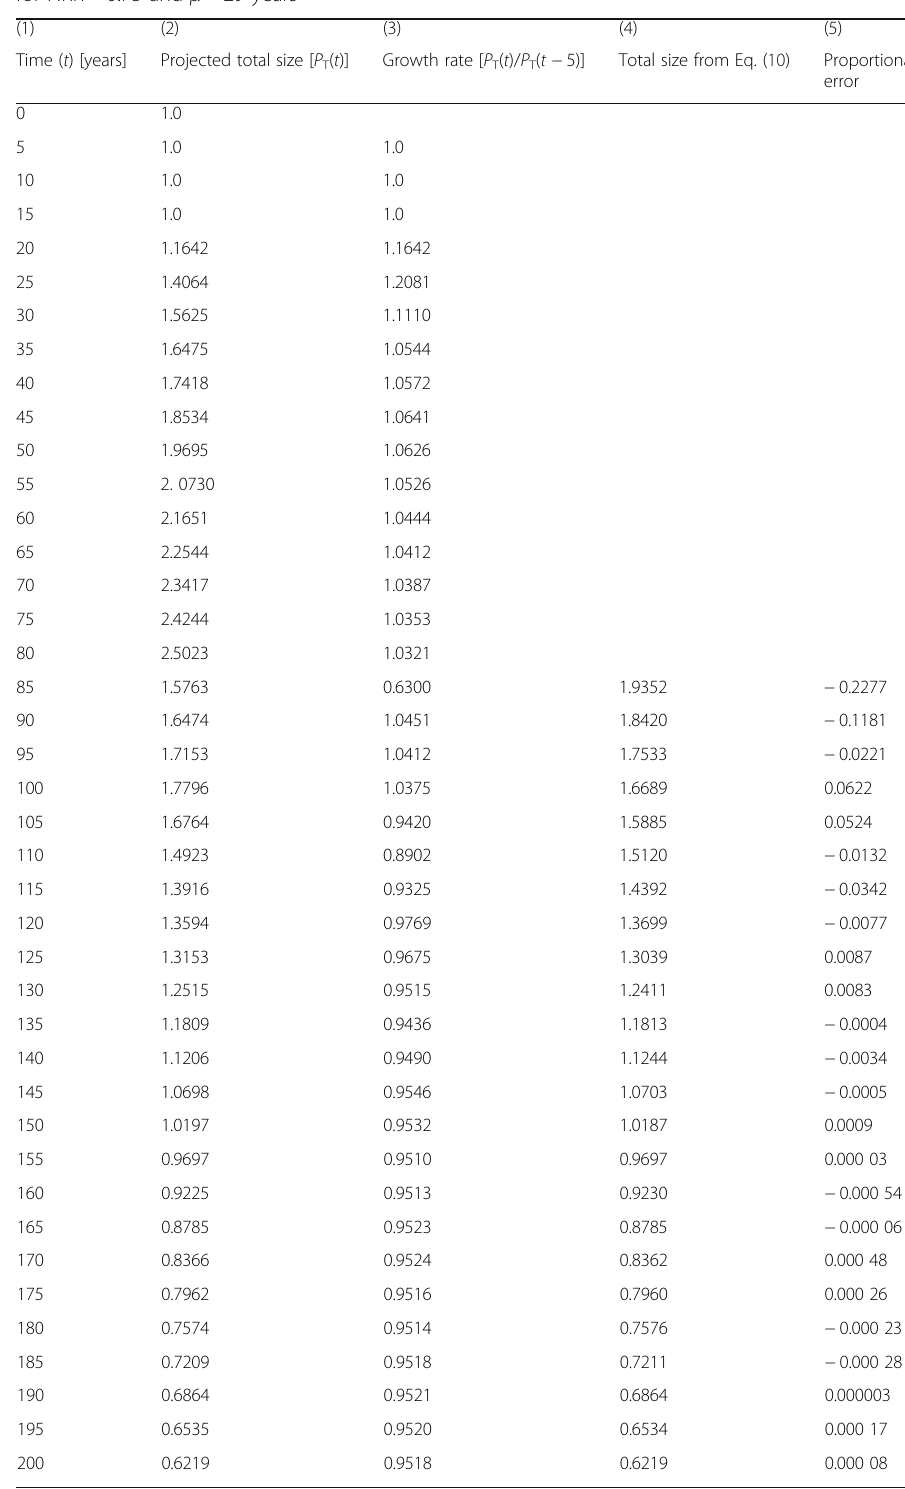
Table 2 The total size of a cohort and its descendants, as calculated by projection and by Eq. (10), for NRR = 0.75 and μ = 29